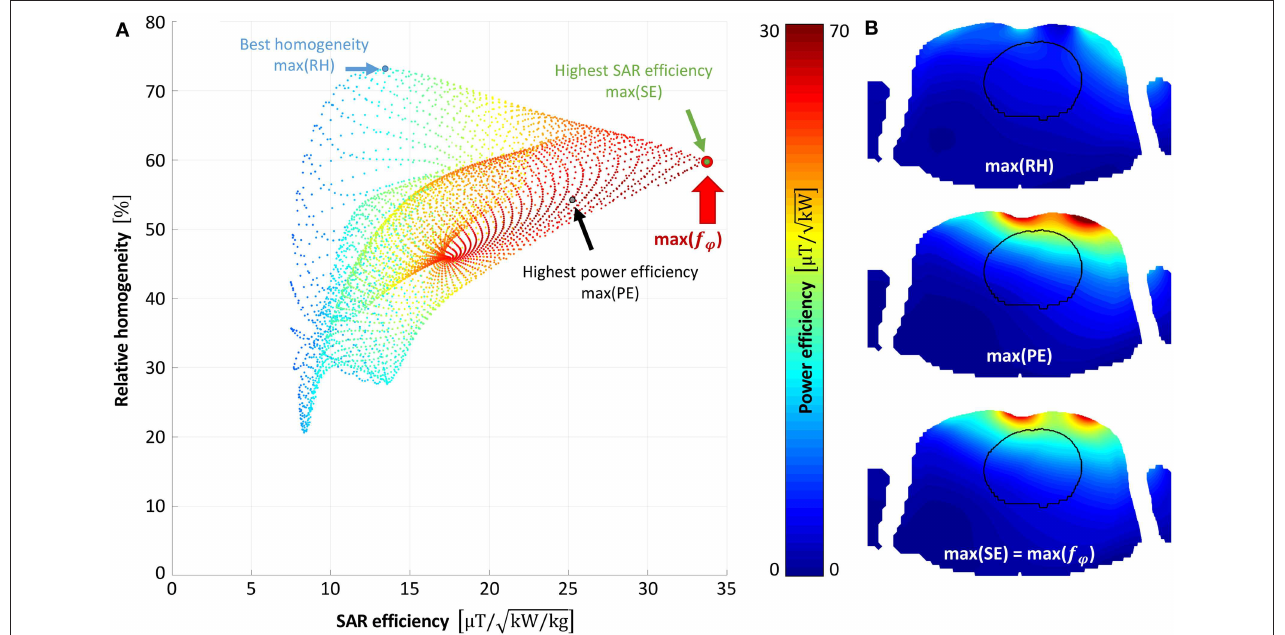
FIGURE 2 | Static B + 1 shimming result. Static B + 1 shimming result for the best-performing design (3-element heart centered with 94 on Duke is shown. (A) depicts the resulting point cloud (5,184 points), where each point represents the array’s performance in terms of relative homogeneity (RH), power efficiency (PE), and SAR efficiency (SE), for a certain phase set. The optimal phase set is chosen where the merit function f ϕ is maximized (depicted as a red circle). In (B) the resulting B